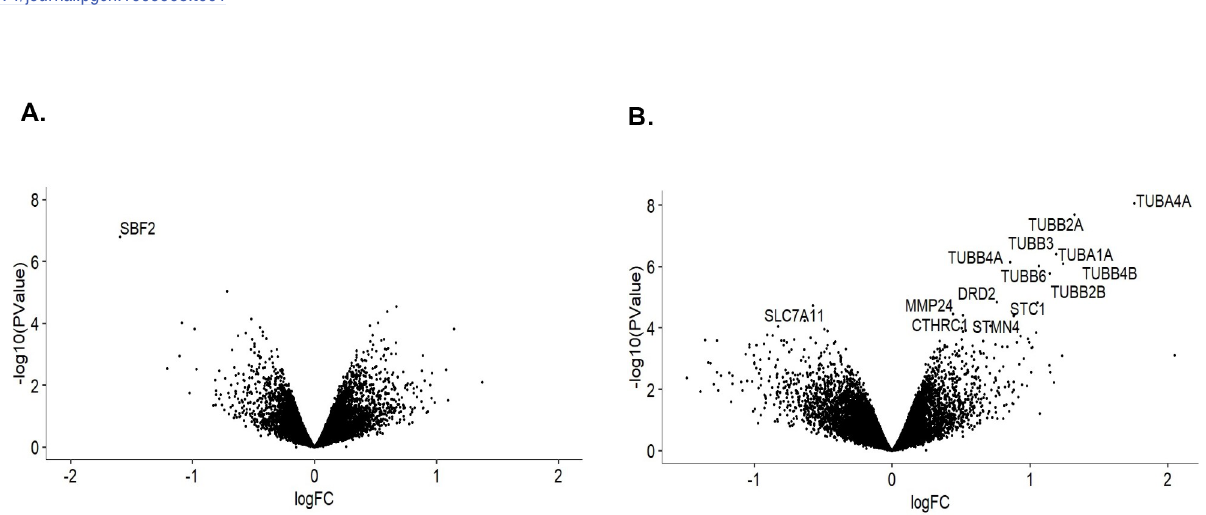
Fig 6. Paclitaxel-treated si SBF2 cells reveal candidate genes exclusive to this group. A) Volcano plot of the comparison between vehicle-treated NTC and si SBF2 cells. 15,271 differentially expressed genes were detected in the analysis, with SBF2 being the only gene that reached statistical significance (FDR = 0.002, logFC = -1.60.) B) Volcano plot of genes differentially expressed between vehicle- and paclitaxel-treated si SBF2 cells. 15,239 differentially expressed genes were detected, of which 14 reached statistical significance. Data obtained from sequencing six iPSC-dSN cell lines. (PTX = paclitaxel, logFC = log fold-change, FDR = false discovery rate).